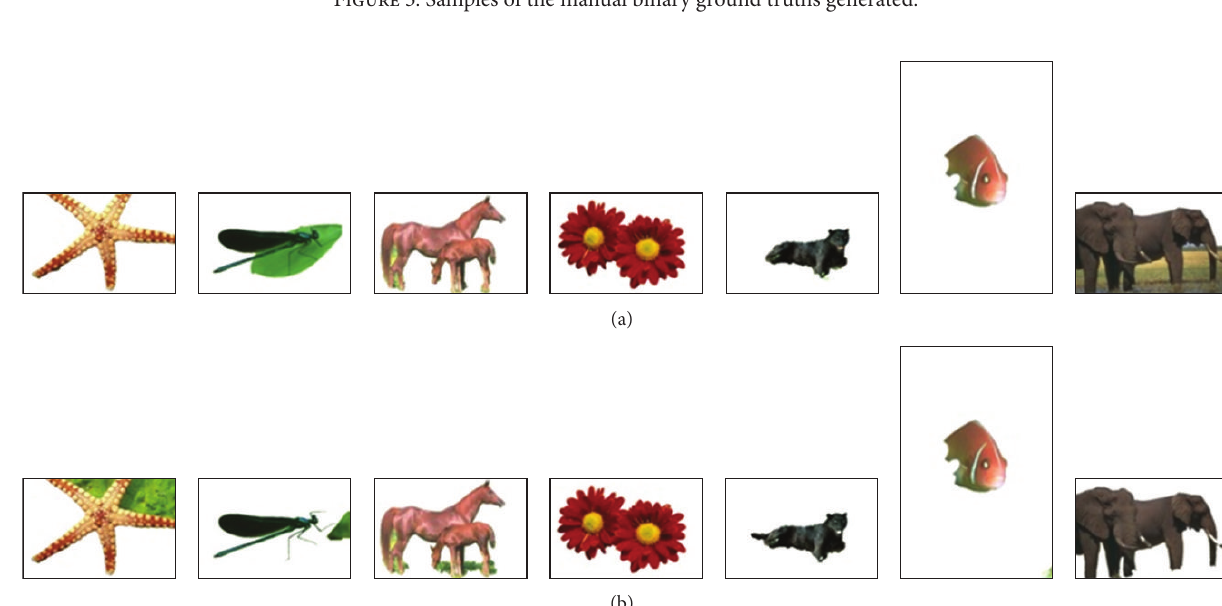
Figure 4: Visual comparison of the segmentation results of (a) original semiautomatic GrabCut and (b) automatic GrabCut initialized using Orchard and